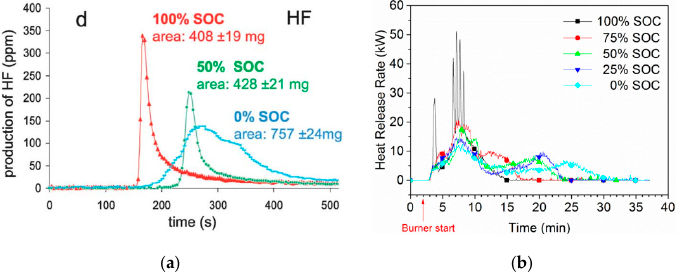
Figure 6. ( a ) Mass flux of HF [d] as a function of time at different state of charge (SOC) [65]; ( b ) heat release rate [66].